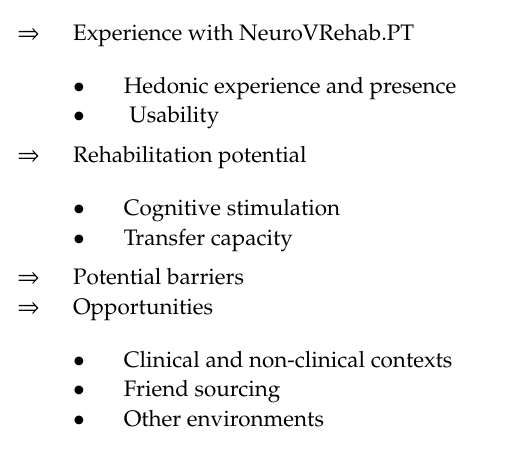
Table 1. Code system developed with the semantic analysis of the